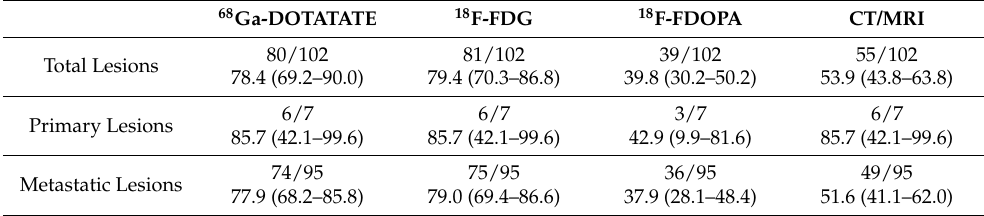
Table 5. Lesion analysis in patients in which all four imaging modalities were performed displaying detection rates and confidence intervals in total SDHA lesions, primary SDHA lesions, and metastatic SDHA lesions. 68 Ga-DOTATATE